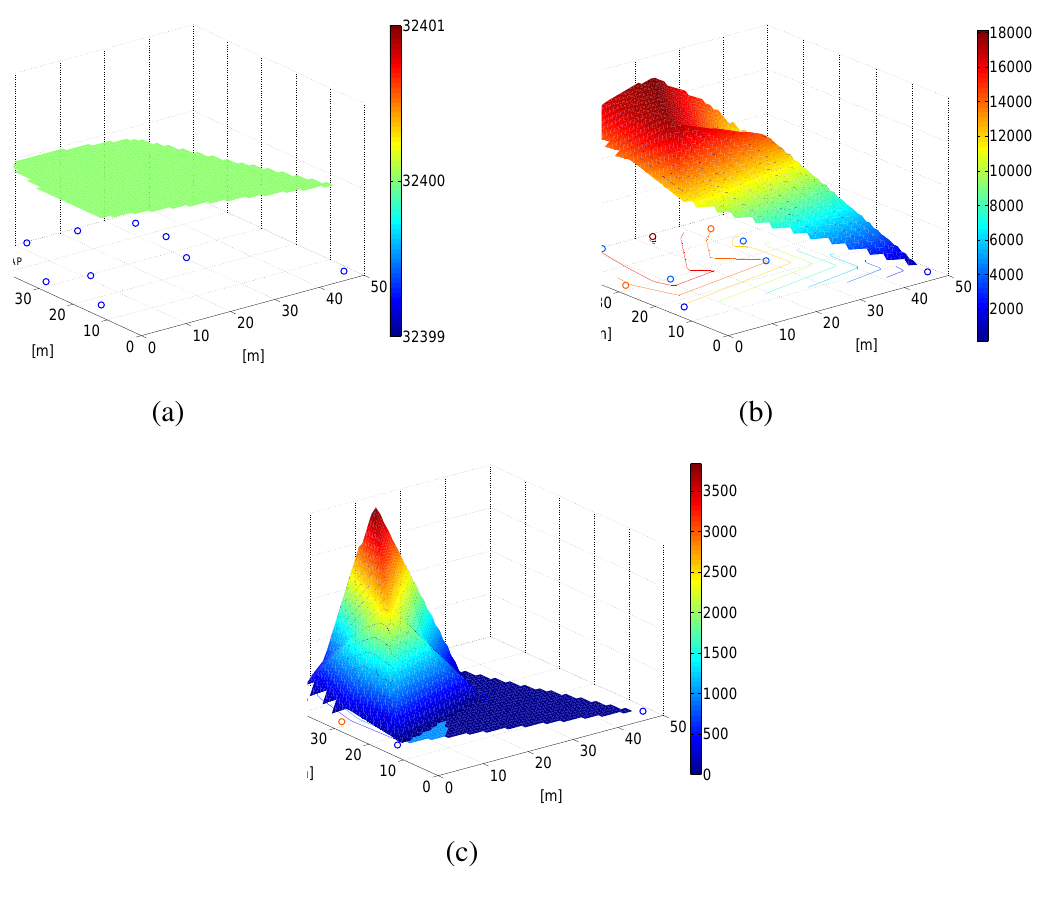
Figure 18. Residual energy with adjacency matrix-based transmission power allocation strategy proposed here, in a scenario with N = 10 nodes after (a) 0 days, (b) 45 days, and (c) 90